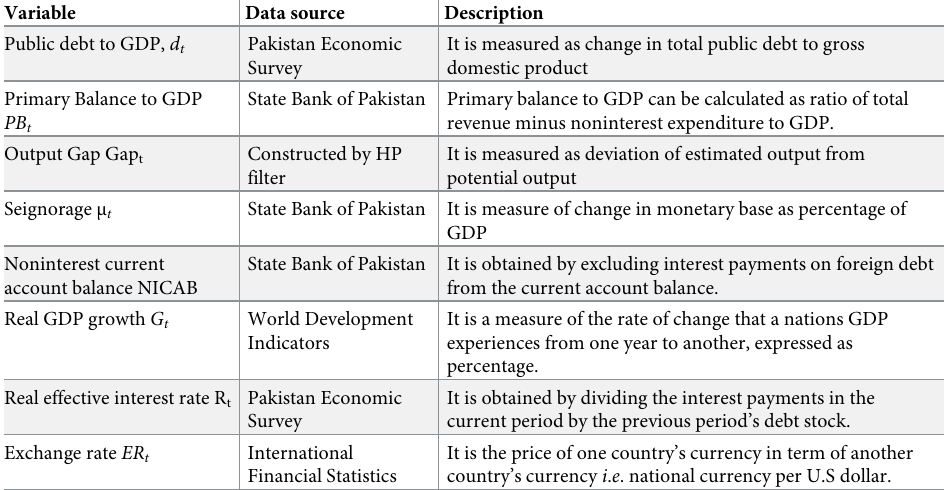
Table 1. Description of